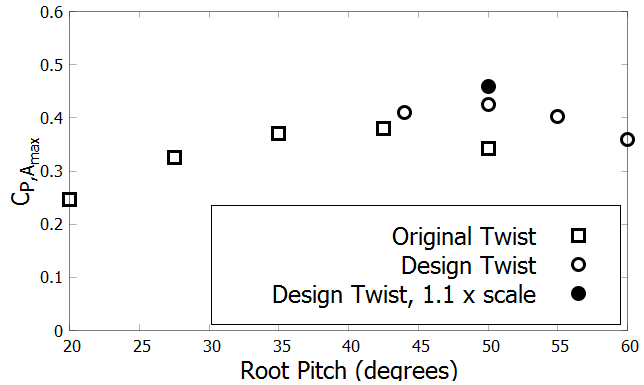
Figure 14. Effect of pitch, twist, and scale for a ducted